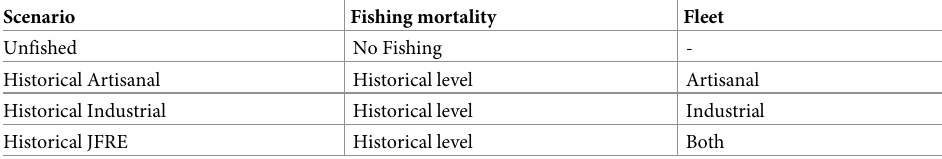
Table 2. Scenarios used to evaluate the effects of historical fishing activity in the